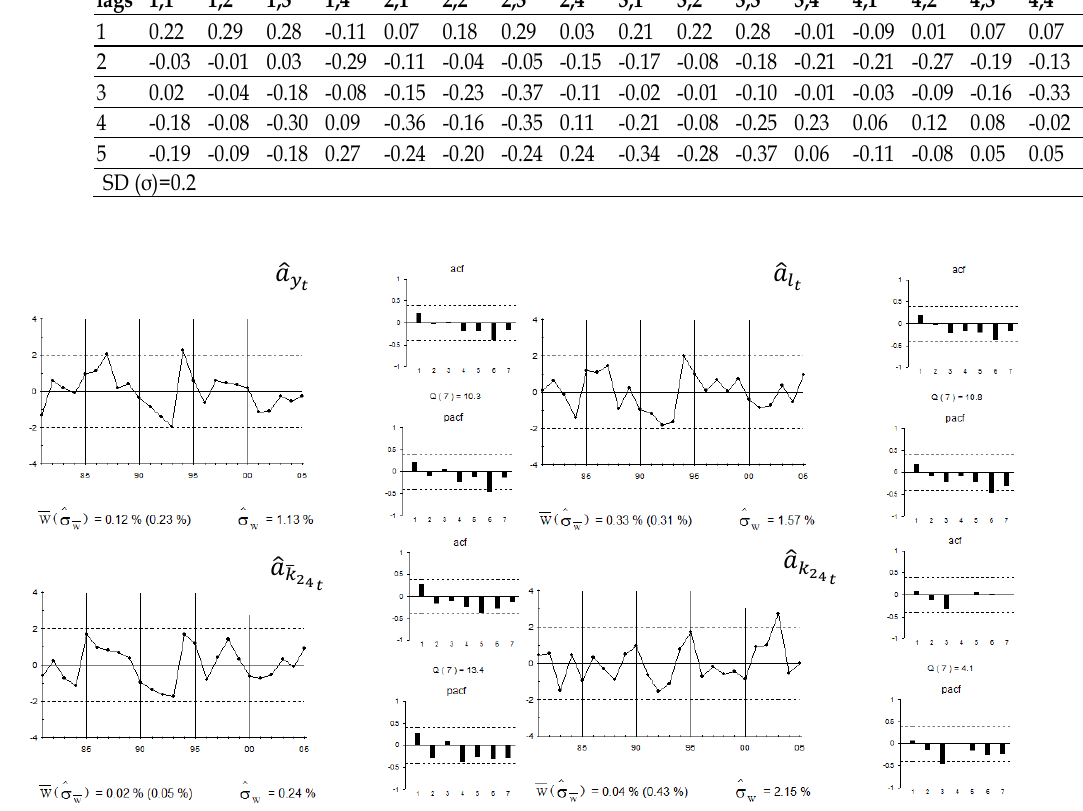
Figure 3. Residual series and their Autocorrelation (ACF) and Partial Autocorrelation (PACF)